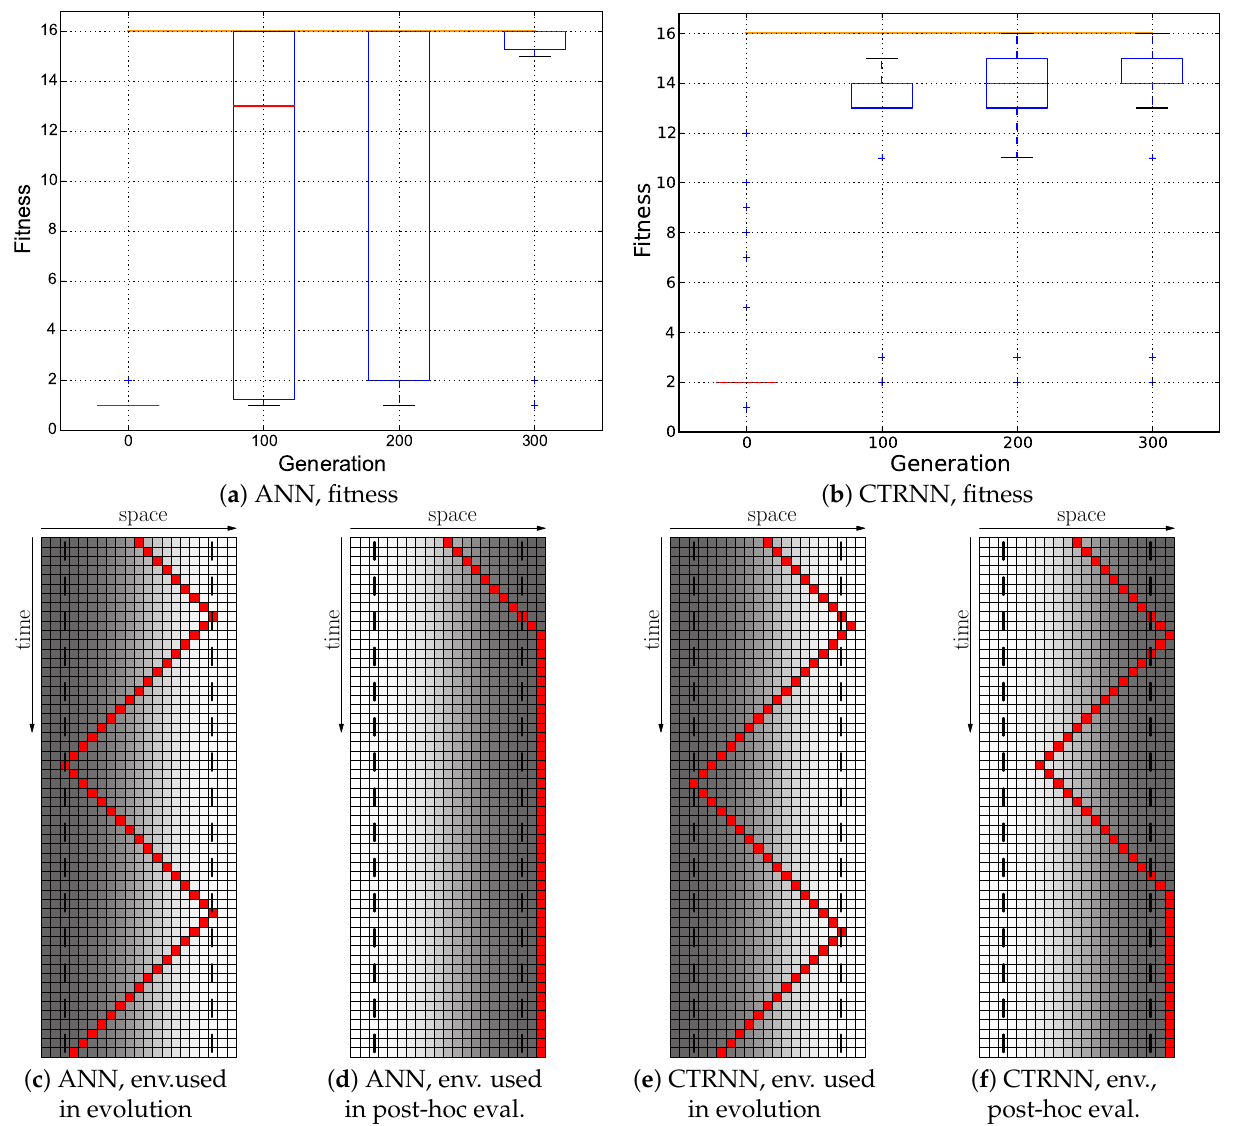
in evolution in post-hoc eval. in evolution post-hoc eval. Figure 6. Single Environment, Switch fitness = F ( 1,0,0 ) . Top row: fitness dynamics of the ANNs (left) and CTRNNs (right). The horizontal orange line indicates the maximum fitness achievable by a reactive Wankelmut controller, as it was achieved by the simple hand-coded controller. Bottom row: trajectory of the best performing genome of each controller type in the environment used in evolution versus a run in a flipped environment as a post-hoc evaluation (only the initial 56 time steps of 250 time steps are